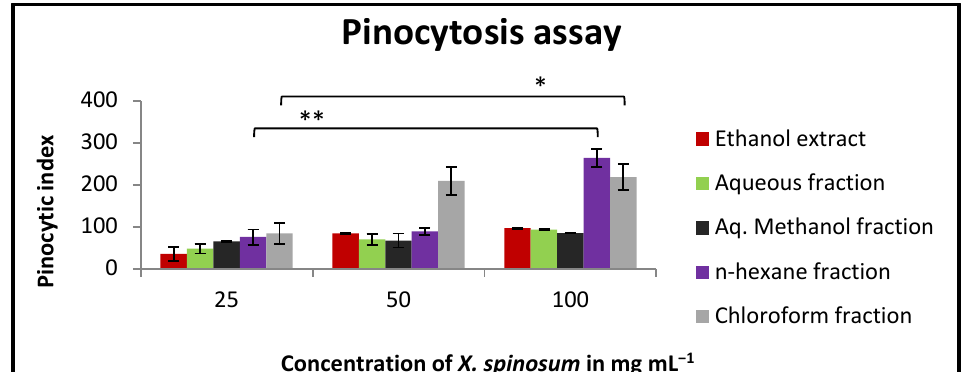
Figure 8. In vitro pinocytic assay using the neutral red method on peritoneal macrophages treated with different concentrations (25–100 mg mL − 1 ) of X. spinosum extract and fractions. N-hexane fraction showed the highest pinocytic index (263). Results are expressed as means of three independent experiments (bars) ± SEM (lines). Phagocytic index = (OD sample − OD control)/OD control × 100. (* p = 0.005) (** p = 0.003).